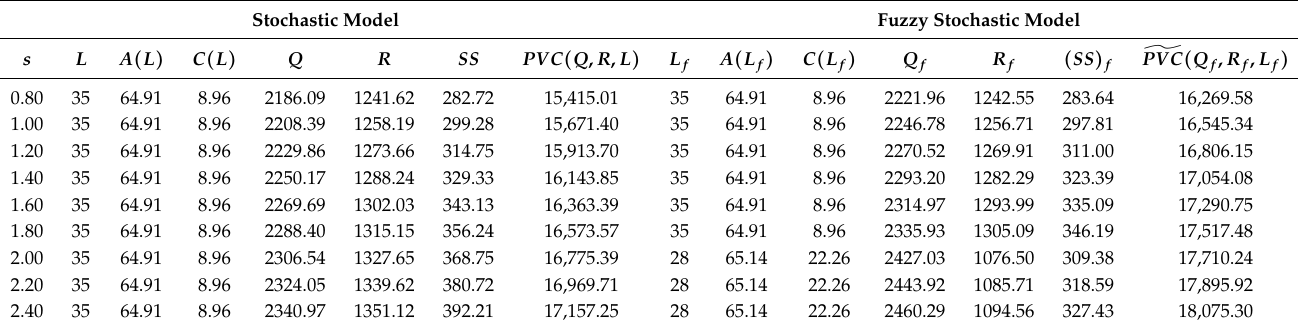
Table 8. Effect of the shortage cost in the stochastic and fuzzy stochastic